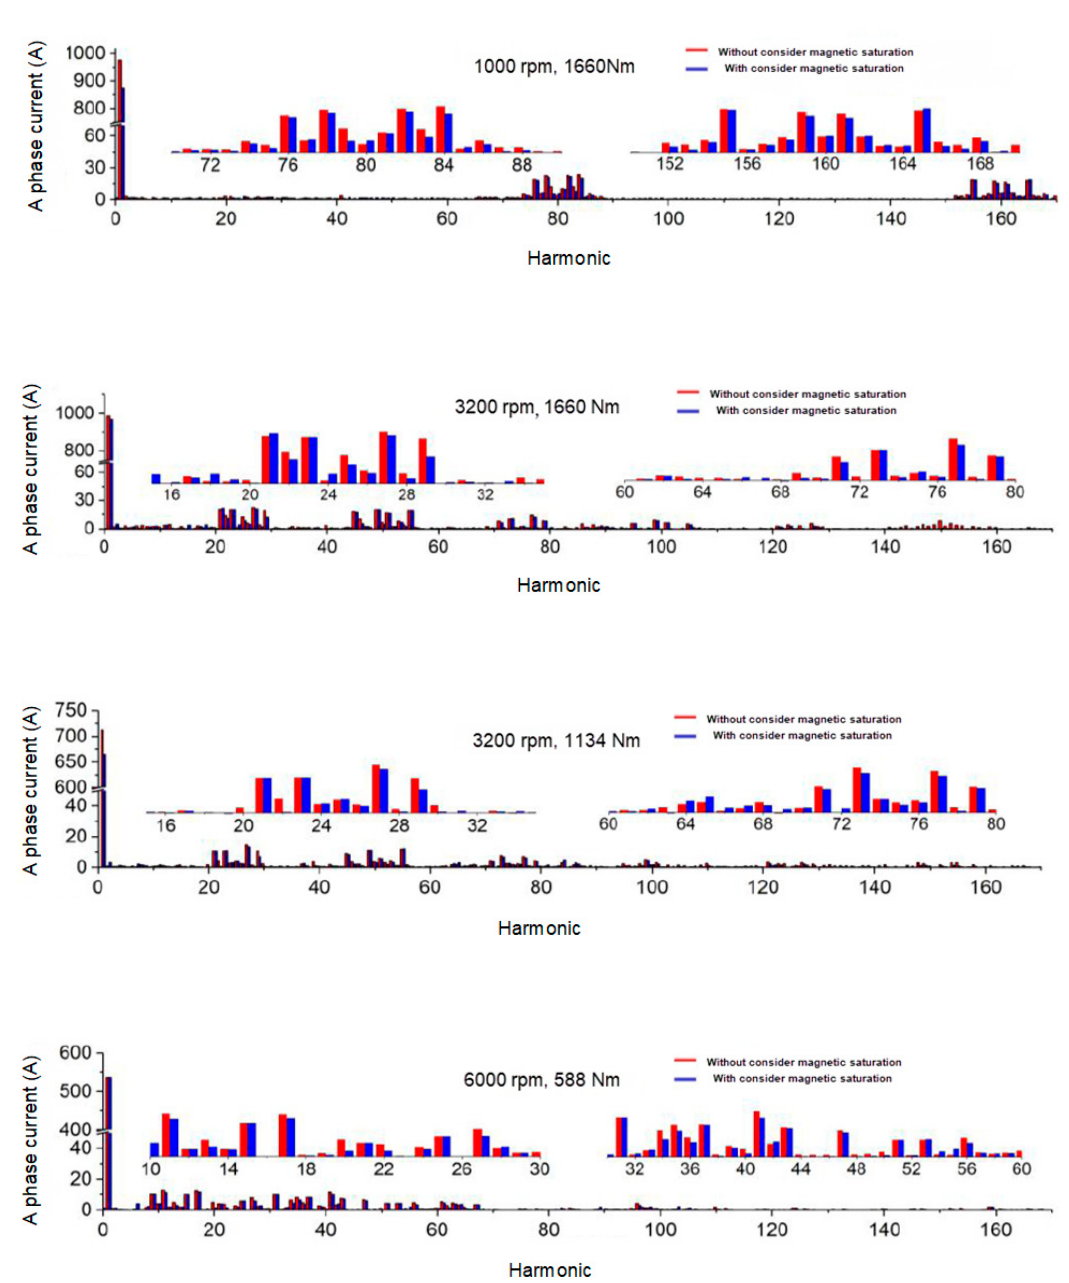
Figure 3. A-phase harmonic current amplitude under different working points of the motor.